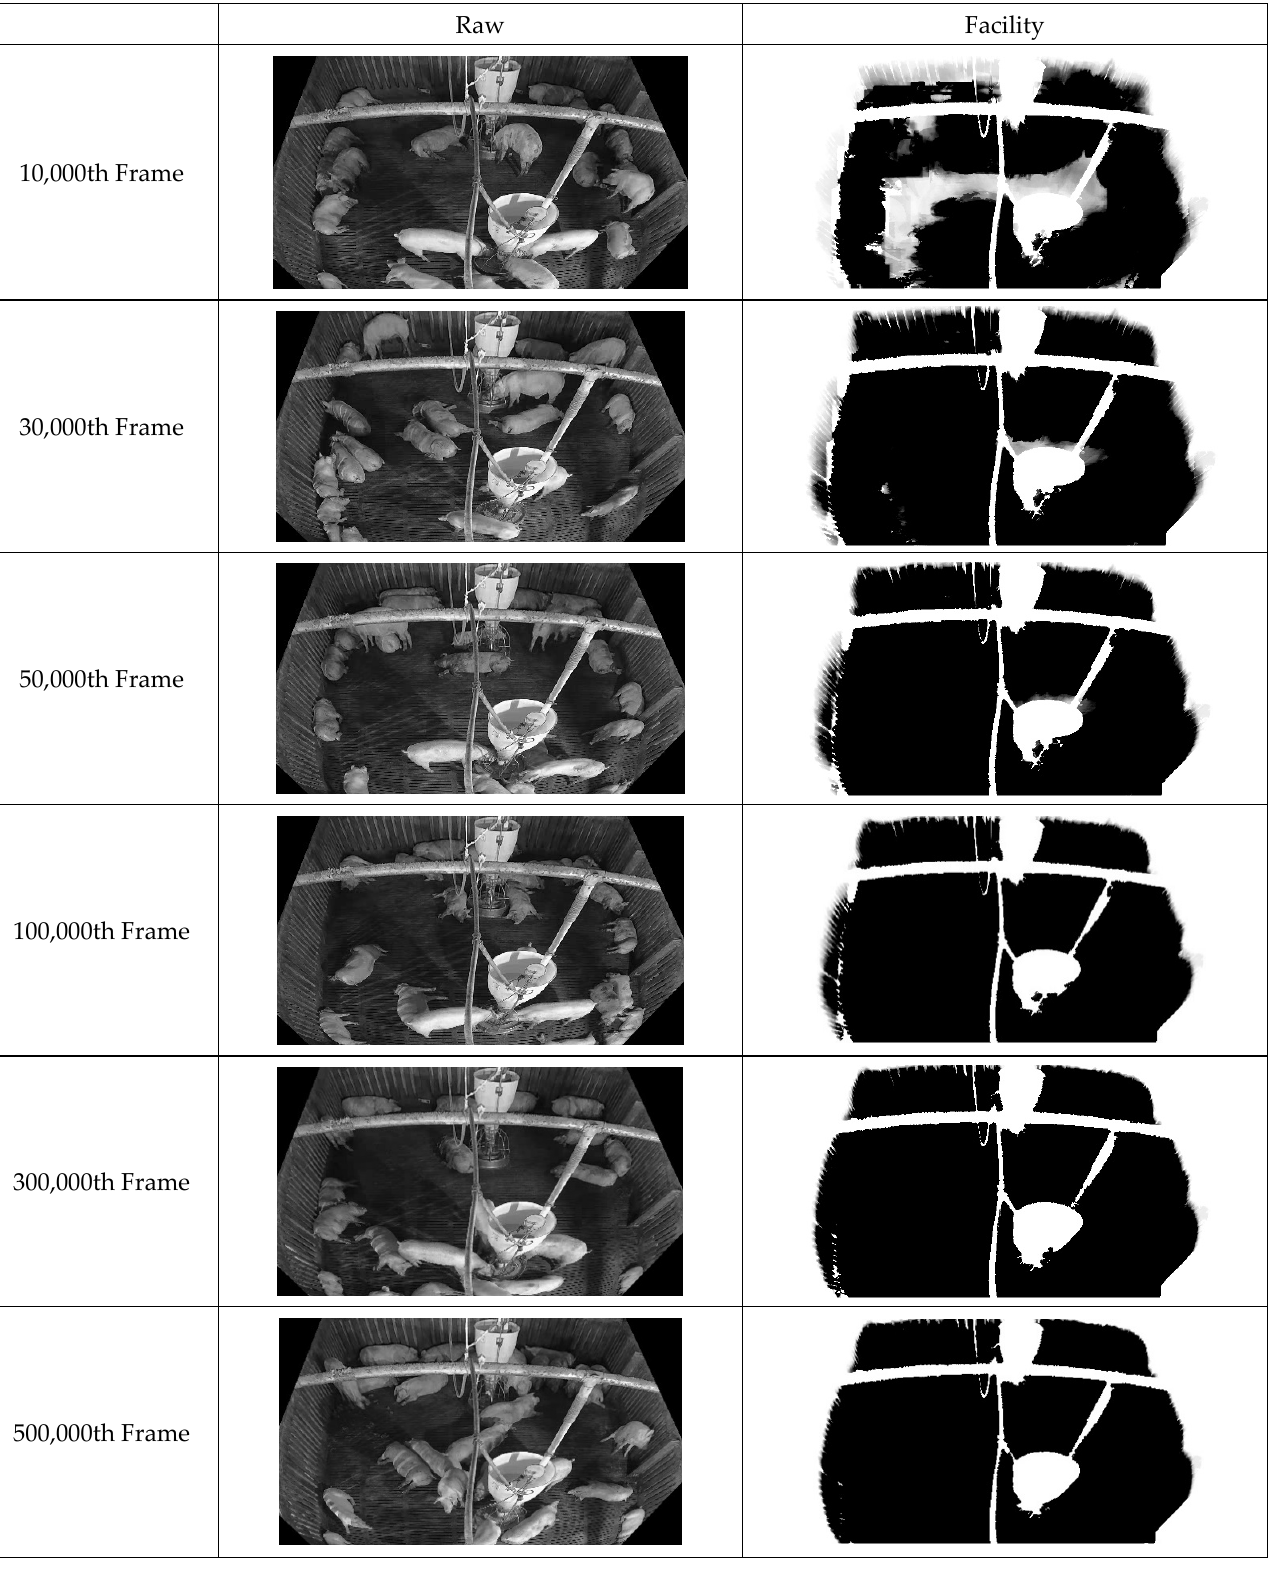
Figure 11. Illustration of Facility Image Generation of 500,000 frames with showing each consecutive 20,000 frames, 200,000 frames.